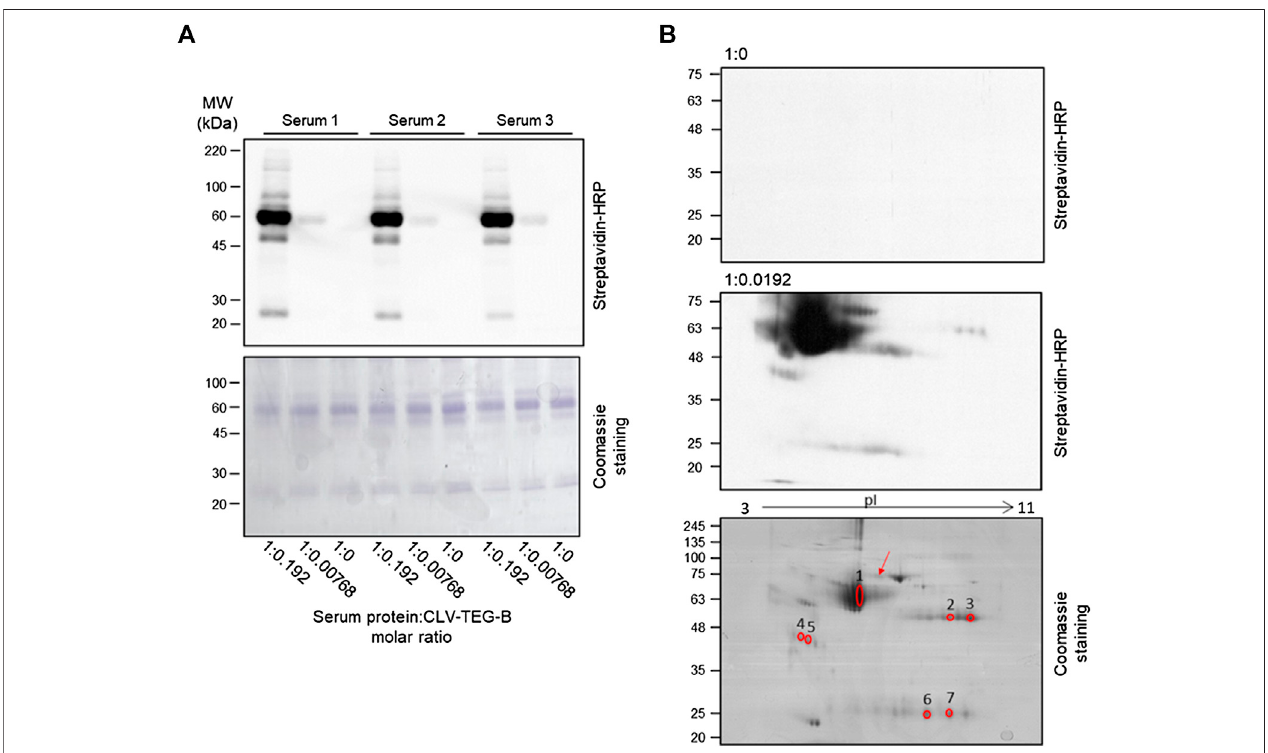
FIGURE 5 | Detection of modi fi cation of serum proteins by clavulanic acid (CLV)-tetraethylenglycol-Biotin (CLV-TEG-B) and identi fi cation of targets. Human sera were incubated in the presence of CLV-TEG-B for 16 h at 37 ° C. (A) 4 µg aliquots of resulting adducts were analyzed by SDS-PAGE and CLV-TEG-B modi fi cation was detected by blot with streptavidin-HRP and ECL detection. Lower panel shows the Coomassie staining for total proteins visualization. (B) 50 µg aliquots of resulting adducts were subjected to 2D-eletrophoresis on duplicate gels, after which, one of the gels was used for detection of modi fi ed proteins by transfer to membrane and biotin detection with avidin-HRP and the other one was used for protein staining with Coomassie. Matched spots were excised from the gel and used for tryptic digestion and peptide fi ngerprint analysis. The blot in the middle panel is deliberately overexposed in order to show the signals corresponding to modi fi ed immunoglobulin chains. The red arrow point towards a spot that could be proposed as transferrin, on the bases of its molecular weight and isoelectric point.